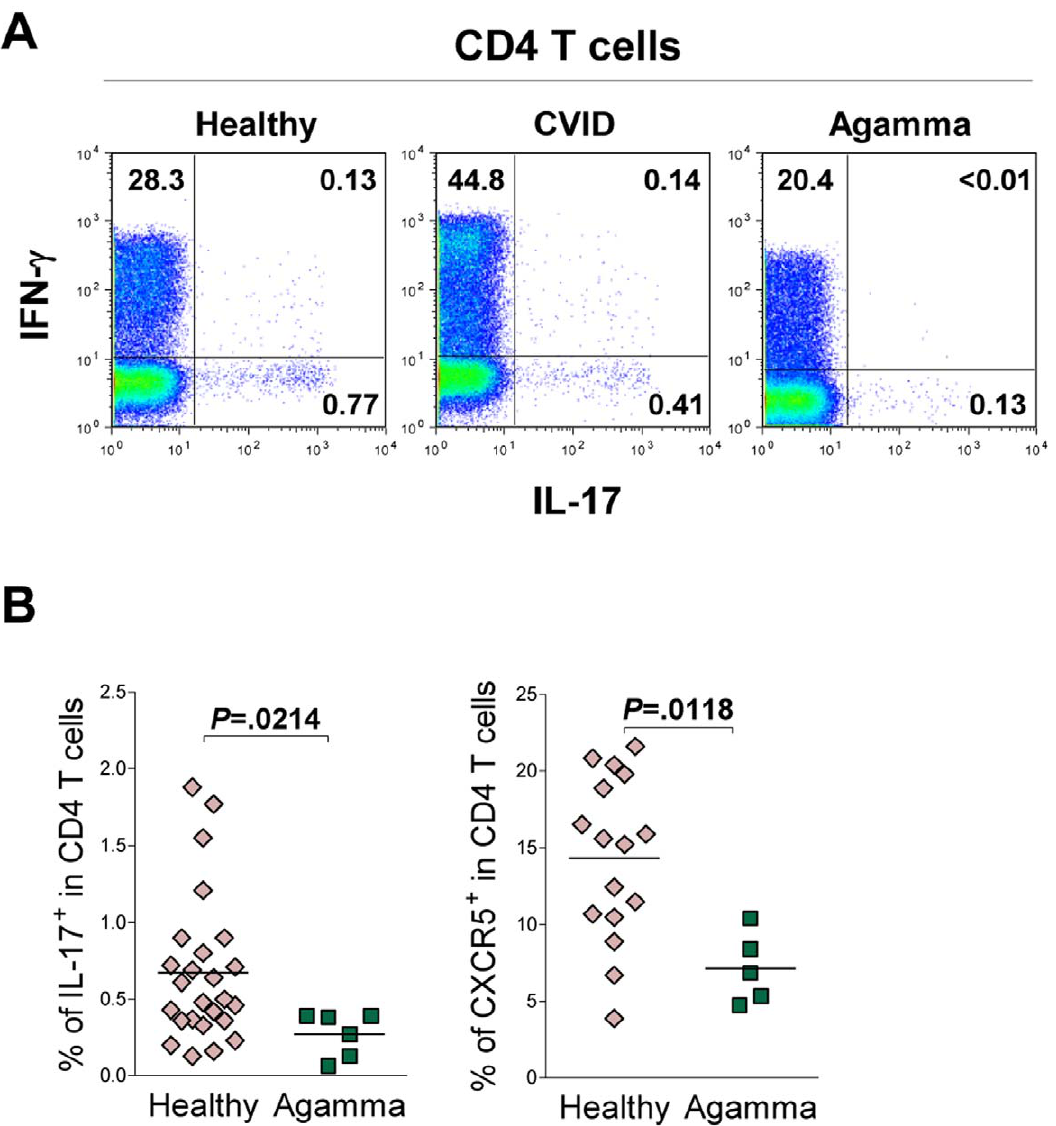
Figure 2. Decreased frequency of Th17 cells in individuals lacking B cells. ( A ) Representative dot-plots of the analysis of IFN- c and IL-17 production by CD4 T cells, determined by intracellular staining, for a healthy individual (left), a CVID patient (middle) and a Congenital Agammaglobulinemia (Agamma) patient (right). Numbers inside dot-plots represent the proportion of cells expressing the markers. (B) Frequency of Th17 cells (left) and CXCR5 + CD4 T cells (right) in healthy individuals and Congenital Agammaglobulinemia patients (Agamma). Each symbol represents one individual. Bars represent mean. Data were compared using Mann-Whitney test, and P values are shown.